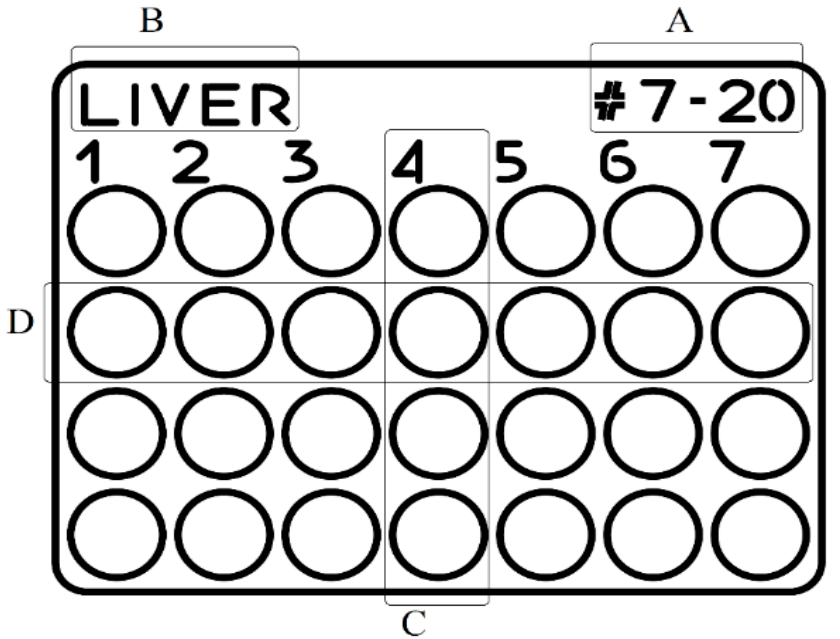
Figure 1. Tissue microarray design (CorelDraw Graphics Suite): ( A ) project number, ( B ) type of organ, ( C ) animal ID (columns 1 to 7), ( D ) processing protocol (four lines). The circles represent the 6 mm diameter receptacles where the tissue cores were inserted.